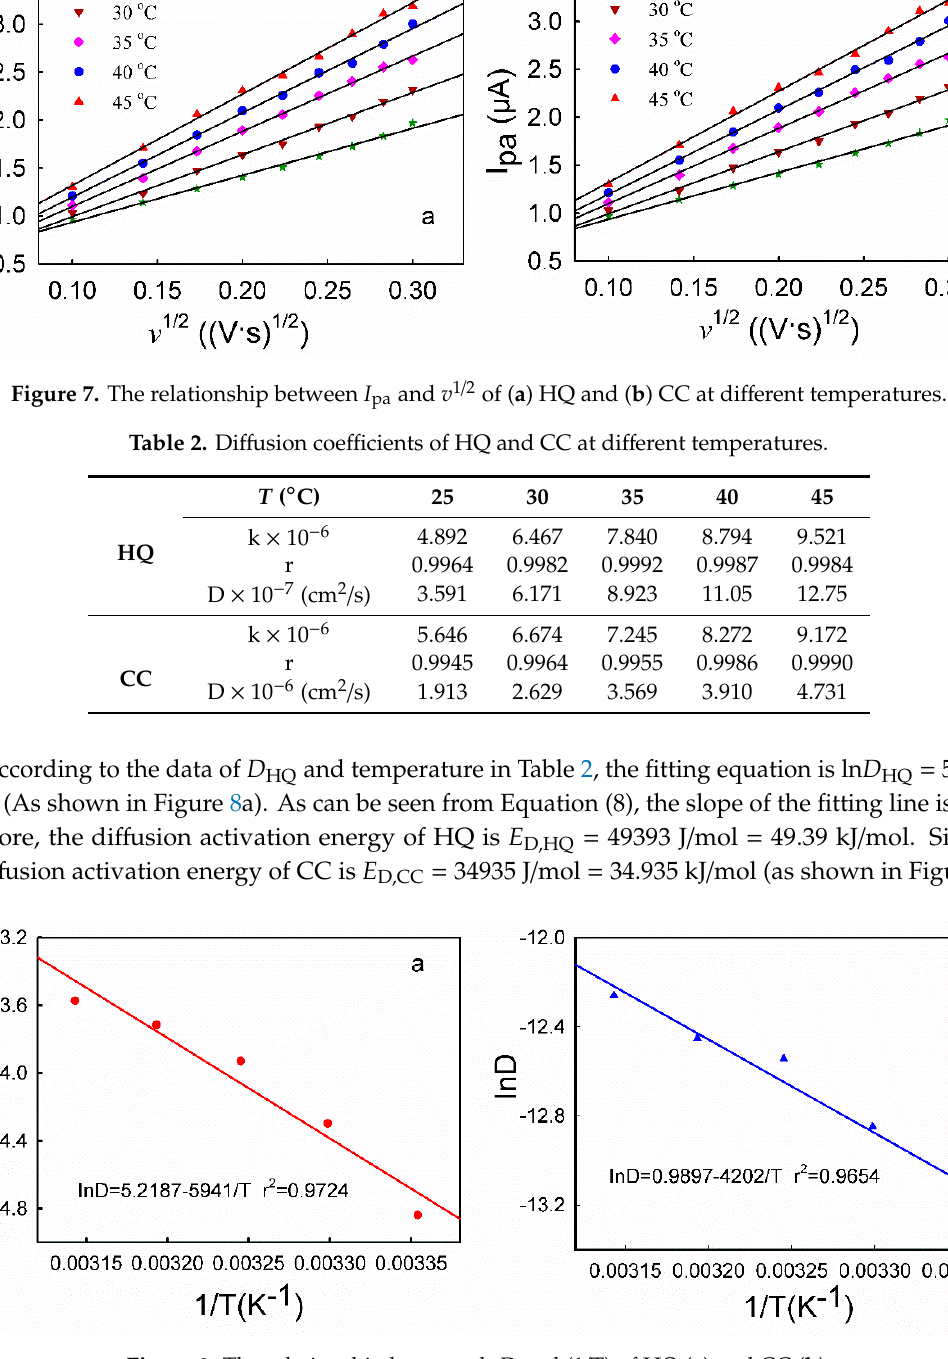
Figure 8. The relationship between ln D and (1 / T) of HQ ( a ) and CC ( b ).